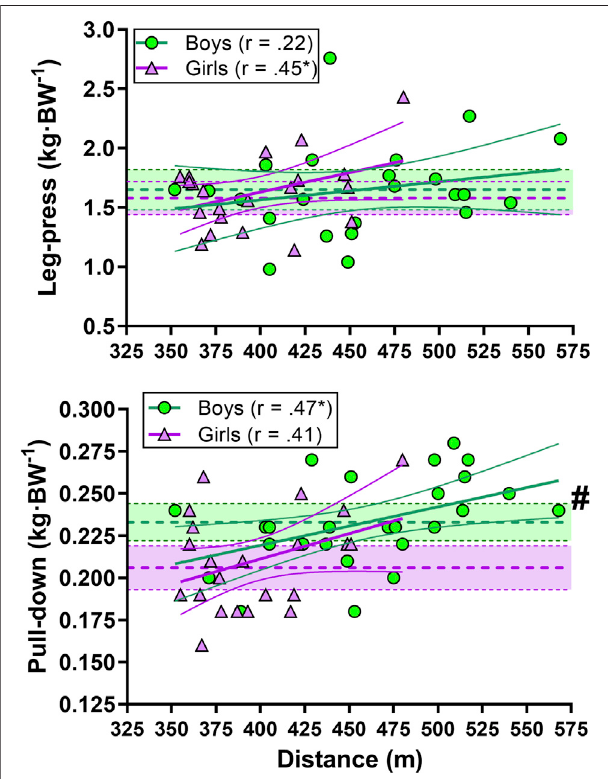
FIGURE4| Correlationbetweenindoorrollerski3-minmaximaluphill(8 ° ) time-trial (TT 3min ) performance and leg-press (upper panel) and pull-down (lower panel) strength. Green circles represent individual values for the boys. Purple triangles represent individual values for the girls. Shaded areas with dotted lines in the middle represent mean ±95% con fi dence interval (CI) (green area for the boys and purple for the girls). Thick and narrow lines represent the best fi t regression line and the 95% con fi dence bands (green linesfortheboys andpurpleforthegirls). *Correlation issigni fi cantat the0.05 level. # signi fi cant difference between boys and